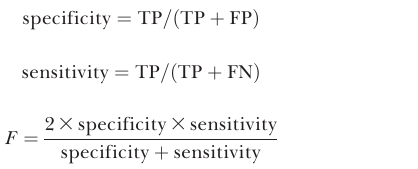
Figure S2. SVM Parameter Optimization (A)Performanceof theSVMsfor differentvaluesof g in theradialbasis function kernel when other parameters were fixed ( C ¼ 16; j ¼ 0.5). (B) Performance of the SVMs for different values of C (trade-off between training error and margin) when other parameters were fixed ( g ¼ 1; j ¼ 0.5). Found at DOI: 10.1371/journal.pgen.0020029.sg002 (215 KB TIF). Figure S3. SVM Error Estimates Provided by SVM light For each cross-validation run, the xi-alpha estimate (a pessimistically biased estimator) and the leave-one-out estimate of the generalized error were obtained from SVM light output after the training. The leave-one-out estimate was similar to our reported error for 10-fold cross-validation. Table S1. Cross-Validation Performance of SVMs Trained on Differ- ent ncRNA Sets Table S2. Feature Weights Determined by the